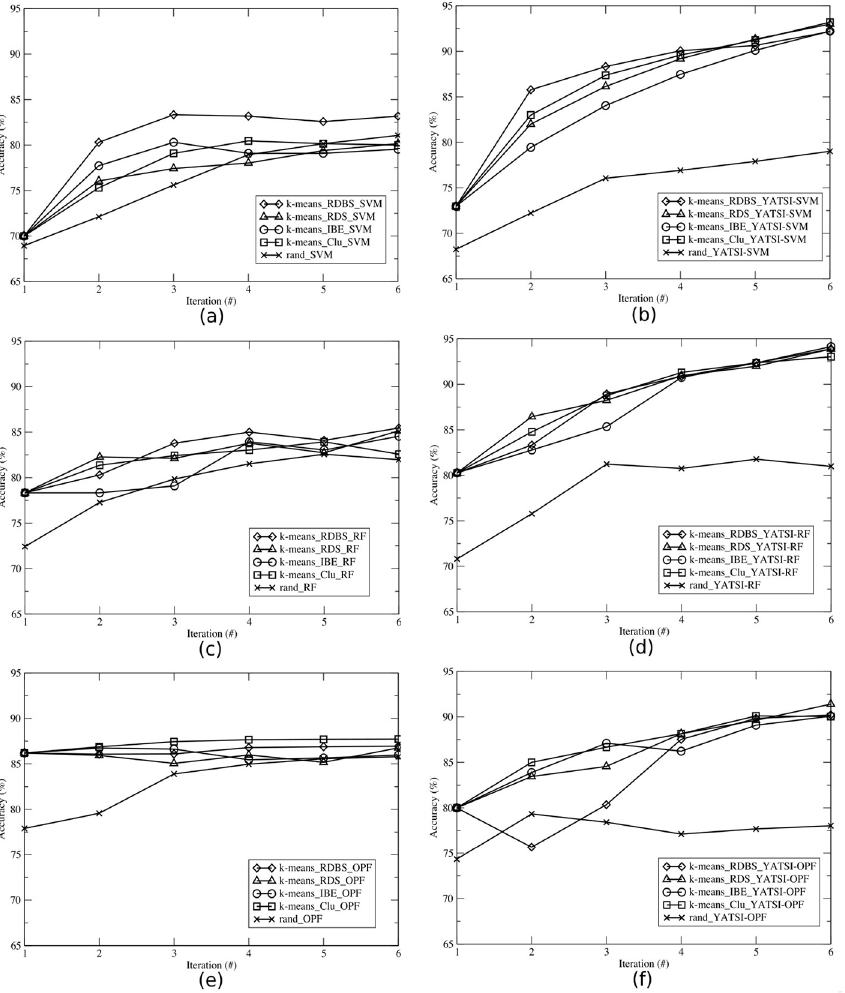
Fig 6. Average accuracies per iteration obtained by each selection strategy (RDBS, RDS, IBE, Clu, and rand), using the E.coli dataset and the classifiers: (a) SVM, (b) YATSI-SVM, (c) RF, (d) YATSI-RF, (e) OPF, and (f)